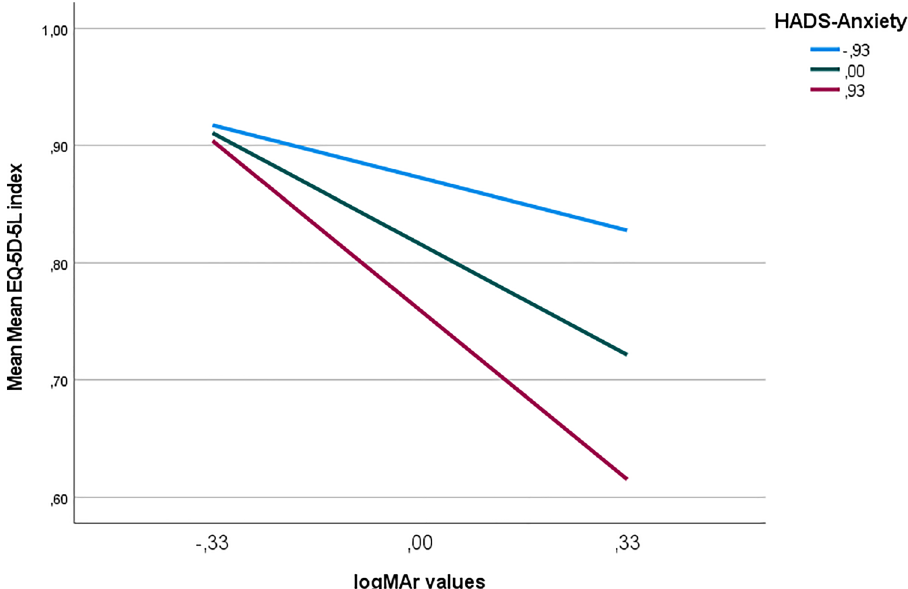
Figure 2. Results of the significant moderation model for the conditional relationship between Visual Acuity (logMAR values) and Health-related Quality of Life (EQ-5D-5L index), moderated by anxiety (HADS-A scores). Higher logMAR values mean worse visual acuity. The light blue regression line shows the relationship between EQ-5D-5L index and logMAR values at 1 SD below the mean on HADS-Anxiety (− 0.93). The dark blue line shows the relationship between EQ-5D-5L index and logMAR values at the mean on HADS-Anxiety (0.00). The red line shows the relationship between EQ-5D-5L index and logMAR values at 1 SD above the mean on HADS-Anxiety (0.93).